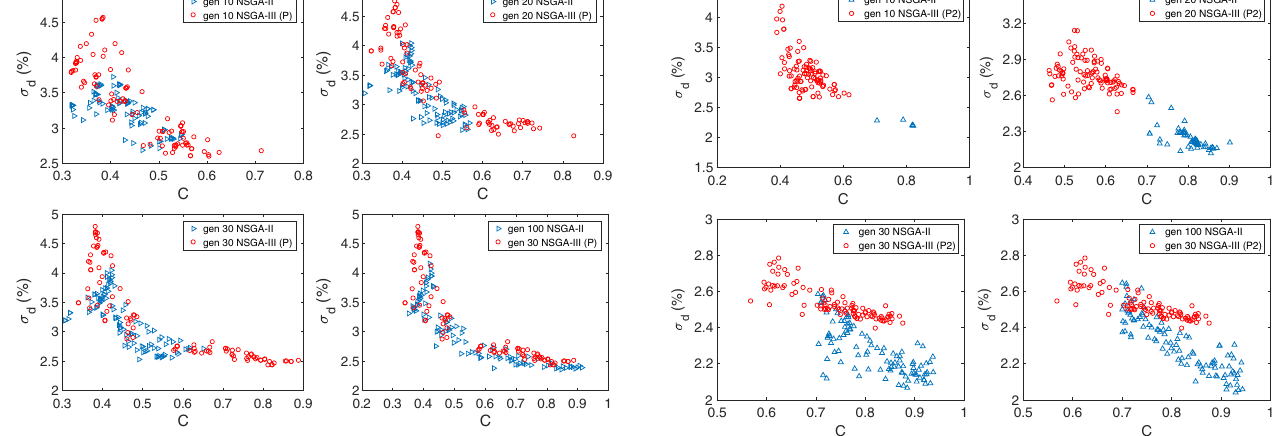
FIG. 12. Projection of the Pareto-optimal front obtained by the NSGA-II (with restrictions on profile factor) and NSGA-III (P2) with a population size of 100 in different generations.